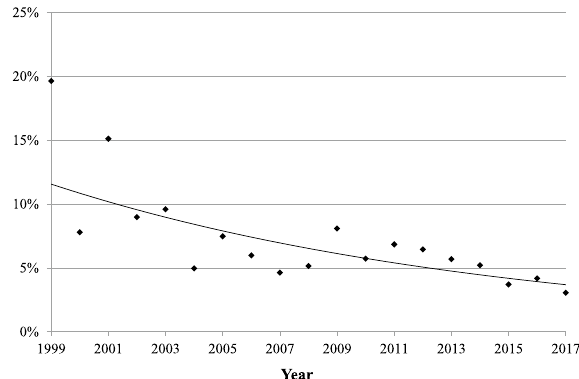
Figure 6. Trends in the estimated case fatality rate of legionellosis in Japan, 1999–2017. The annual estimated case fatality rate is plotted to show an approximate curve. The trend analysis also shows a decrease in the estimated mortality from 1999–2017. For details, see Table